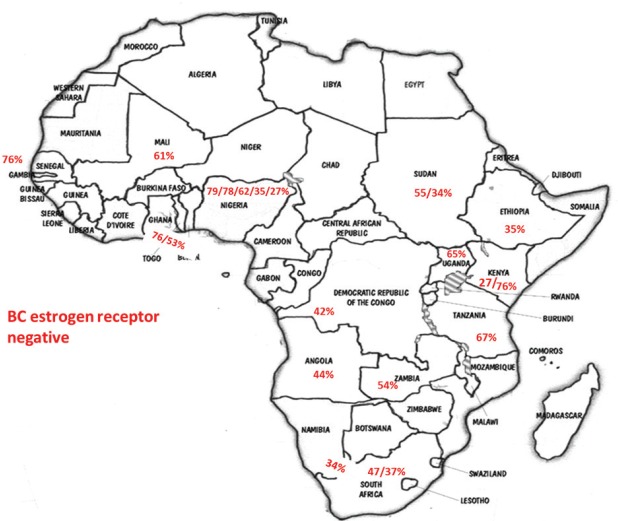
Percentage of negative oestrogen receptor in different SSA countries according to the data of studies referenced in this paper as well as our results (BC – breast cancer).